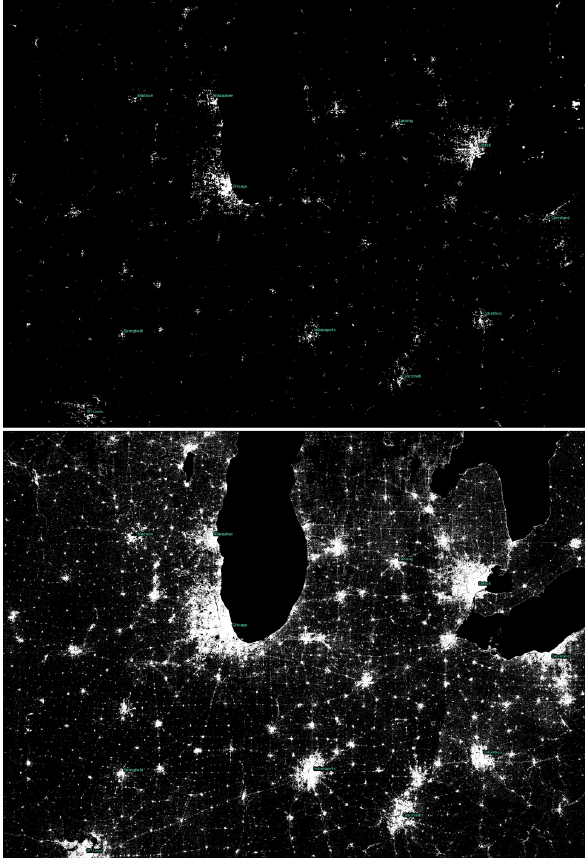
Figure 3: Comparison of the human settlement information ex- tracted from satellite sensors at different spatial resolution in the area of Chicago-Detroit (US). Top: artificial surfaces as reported by the ESA GlobCover using 300-m-resolution MERIS satellite imagery. Bottom: built-up areas as reported by the JRC GHSL using 30-m-resolution Landsat satellite